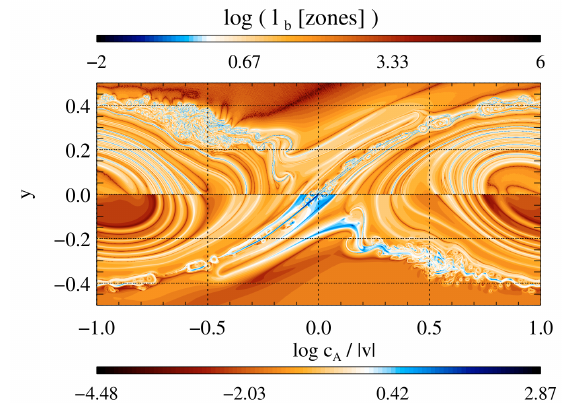
Figure 1. Snapshots of a certain model from [122]. It is taken shortly after the termination of the kinetic amplification phase. The top panel shows the characteristic length scale of the magnetic field, | B | / |∇ × B | in units of the zone size. Regions where magnetic structures are larger than one computational zone are depicted in orange-red colors and blue colors where they are smaller than one zone size. The bottom panel shows the ratio between the Alfvén velocity and the modulus of the fluid velocity. Strongly magnetized regions are depicted in blue, whereas weakly magnetized regions are depicted in orange-red. (Reproduced with permission from [122], c (cid:13) ESO, 2010).